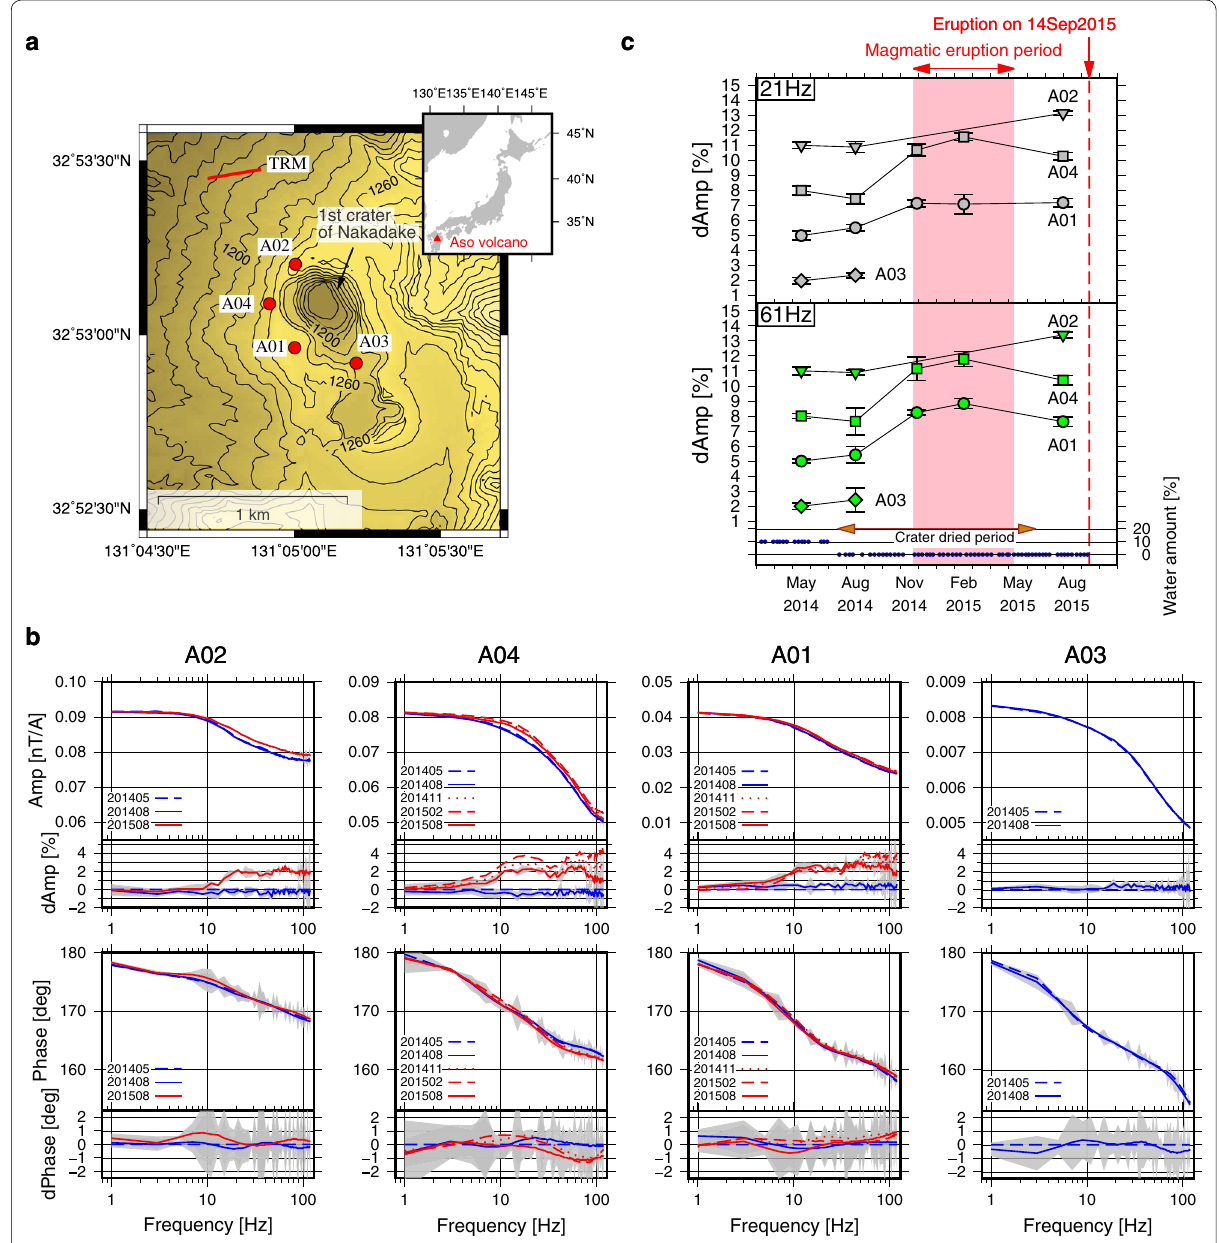
Fig. 1 ACTIVE observation configuration and obtained responses. a Location of Aso volcano and ACTIVE system installed in May 2014 are shown. TRM and A01 to A04 indicate the transmitter and receivers, respectively. b In each panel, upper plots show amplitudes of the ACTIVE response and differences in percent from the values in May 2014, while lower plots depict phases and their differences in degrees from those in May 2014 again. The blue and red lines mean the responses before and after magmatic eruptions began on November 25, 2014, respectively. Only for the responses in August 2014 and August 2015, observation errors are drawn in gray. c Time variations of amplitude are plotted for 21 Hz and 61 Hz. The water amount of the crater lake (measured as the area ratio of the lake surface to the whole crater bottom) is plotted by blue dots (Japan Meteorological Agency 2016), where 100% means the lake surface covering the whole crater